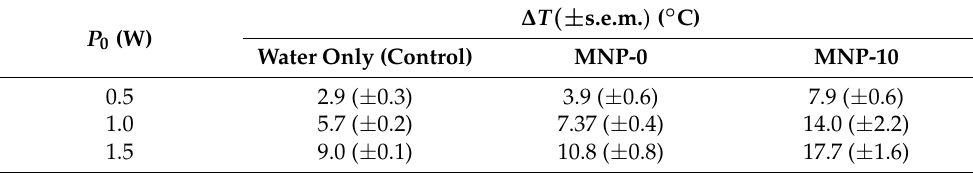
Figure 6. Photothermal heating generation in water results. A comparison of temporal curves for the different samples: ( a ) Water only (control), as well as that consisted of implants ( b ) MNP-0 and ( c ) MNP-10 and deionized water during irradiation with different powers: P 0 (0.5–1.0 W, step size: 0.5 W, λ = 810 nm) for 5 min. For all measurements, T 0 = 29 ◦ C. Table 2. Summary of the mean ∆ T ( ± s.e.m) ( ◦ C) measured after 5 min of irradiation of the 4 different samples, which included water only (a) as well as those consisting of implants: MNP-0 (b), MNP-5 (c) MNP-10 (d) and deionized water during irradiation with different laser powers: P 0 (0.5–1.0 W, step size: 0.5 W) for 5 min.